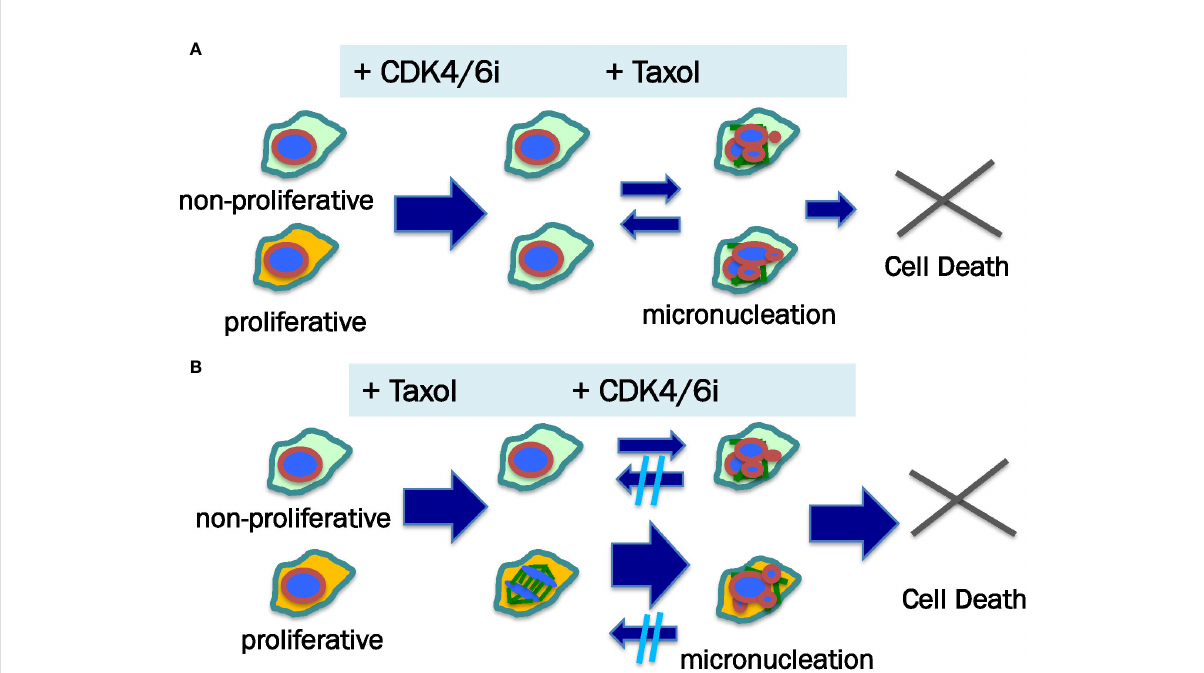
FIGURE 3 Proposed mechanism for sequence-dependent of paclitaxel and CDK4/6 inhibitor in killing cancer cells. Neoplastic cells within a tumor comprise proliferative (illustrated as yellow color cytoplasma) and non-mitotic (illustrated as green color cytoplasma) populations, which may respond to anti-cancer agents differently. (A) When CDK4/6i is added prior to paclitaxel (Taxol), the cancer cells are arrested at G1 phase, producing both cytotoxic and cytostatic effects. Subsequently, paclitaxel induces micronucleation and death of the non-mitotic cells. Some of the micronucleated cells may be able to recover. (B) In the case of paclitaxel addition fi rst followed by CDK4/6i, both proliferative and non- mitotic cell populations undergo micronucleation, though mitotic cells more readily than non-mitotic cells form multiple micronuclei following paclitaxel stimulation (illustrated by small and bigger arrows). It is postulated that CDK4/6i treatment impairs the recovery of paclitaxel-induced damage to the nuclear structure (micronucleation). Thus, paclitaxel — CDK4/6i may have a higher cell killing outcome than CDK4/6i — paclitaxel